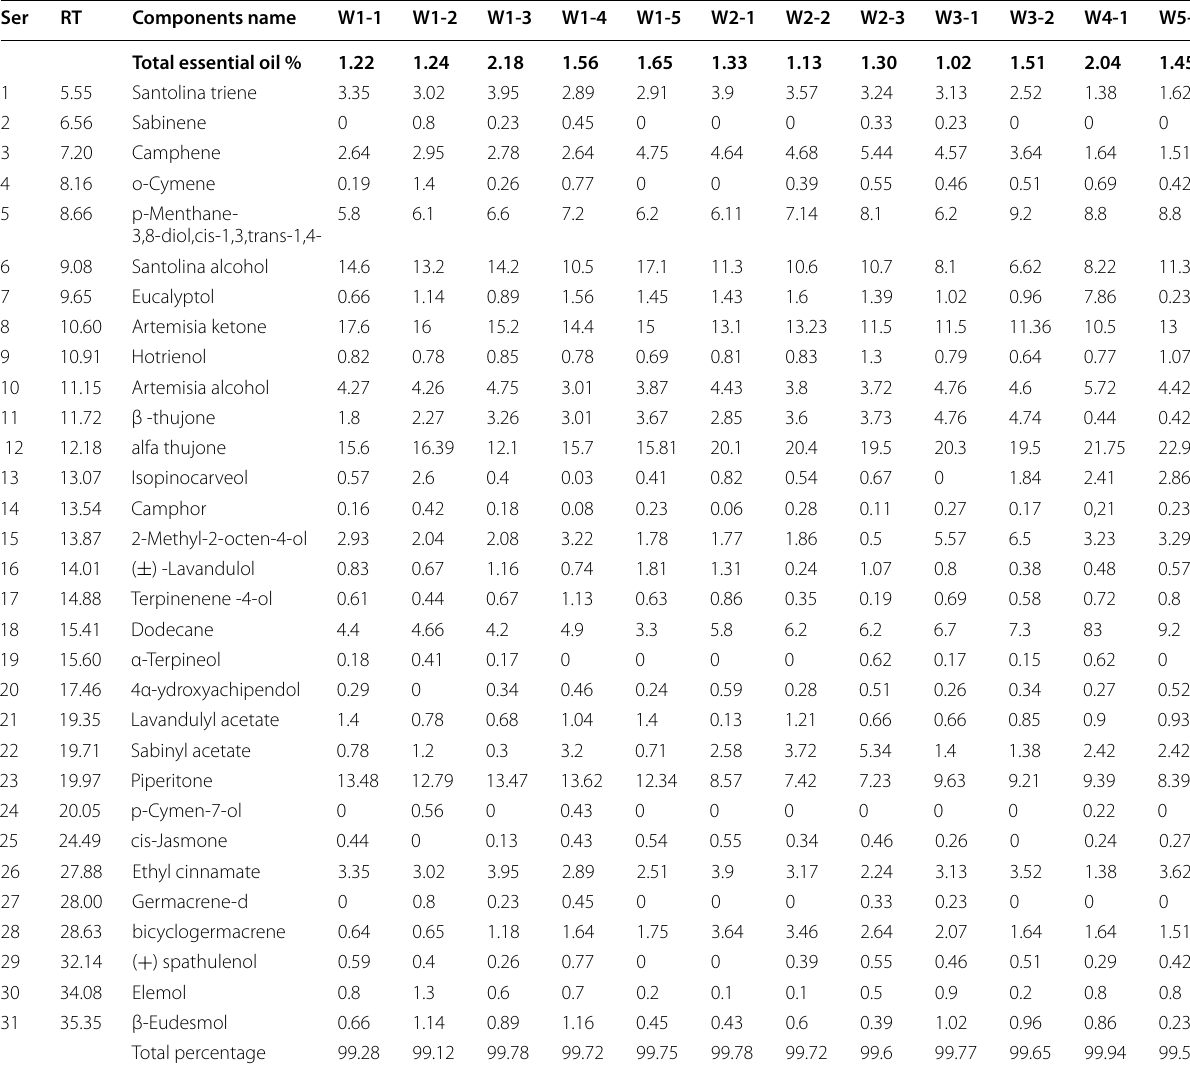
Table 4 Retention time and components name and percentage of each component in the essential oil extracted from 12 individual plants representing five populations of A. fragrantissima Ser